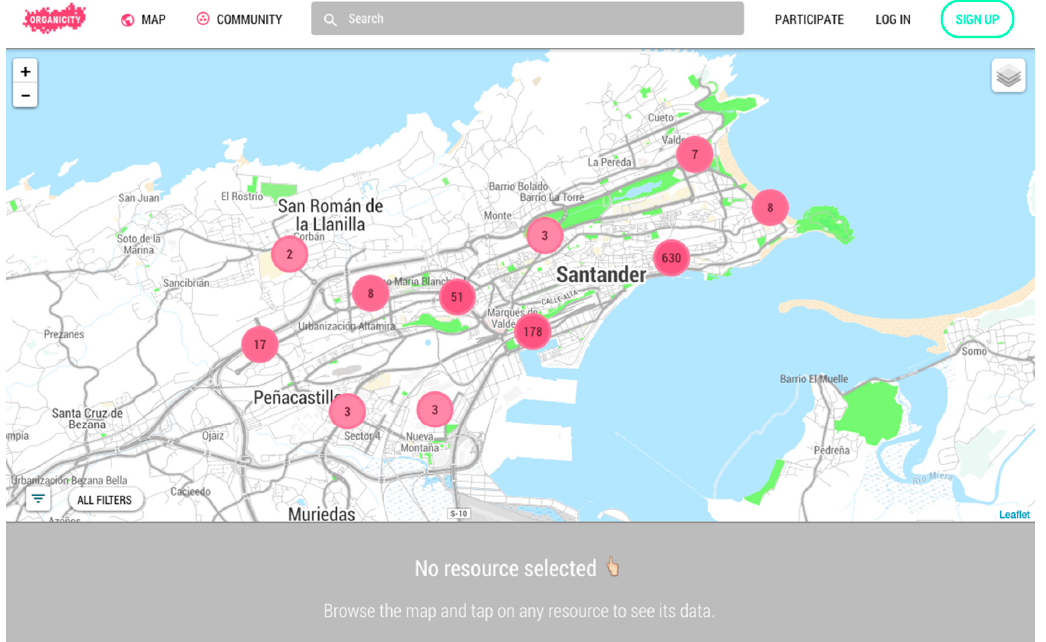
Figure 6. UDO geographic browser view.